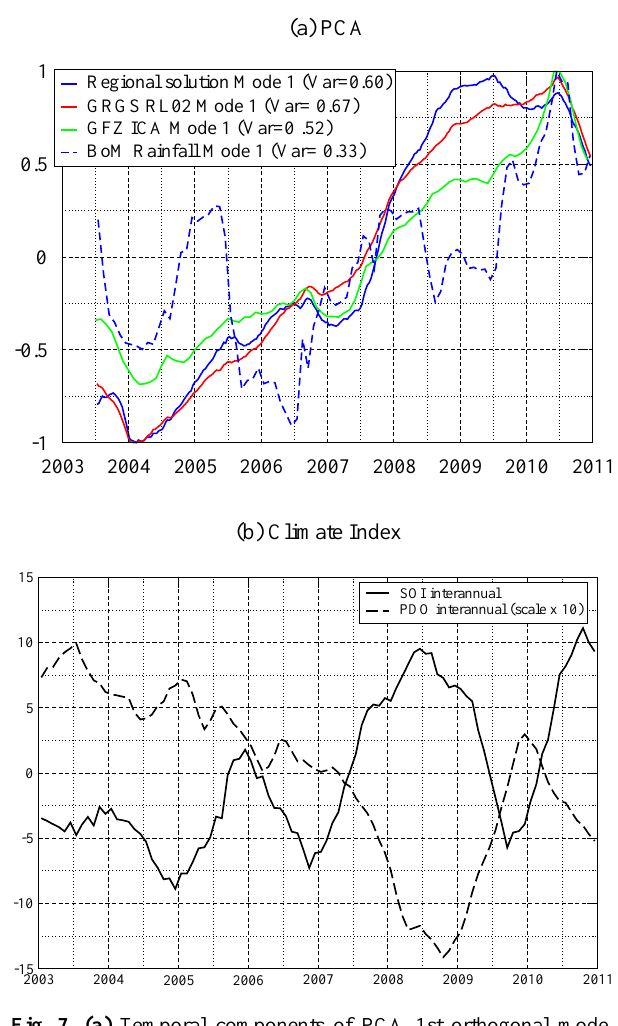
Fig. 7. (a) Temporal components of PCA 1st orthogonal mode. (b) Interannual variations of the Southern Oscillation Index (SOI) and Pacific Decadal Oscillation (PDO).